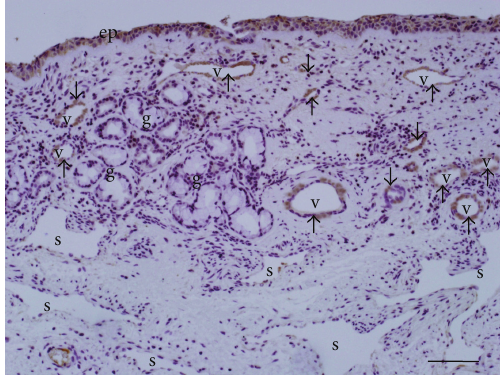
Figure 5: Immunohistochemical staining for histamine H1 recep- tor in human nasal mucosa. The arrows indicate the intense immunoreactivity of H1 receptor on vascular endothelial cells (V) in superficial region. In contrast, deep venous sinusoids (S) have little or no immunoreactivity for H1 receptor. (ep); airway epithelium, (g): submucosal glands. Scale bar = 50 μ